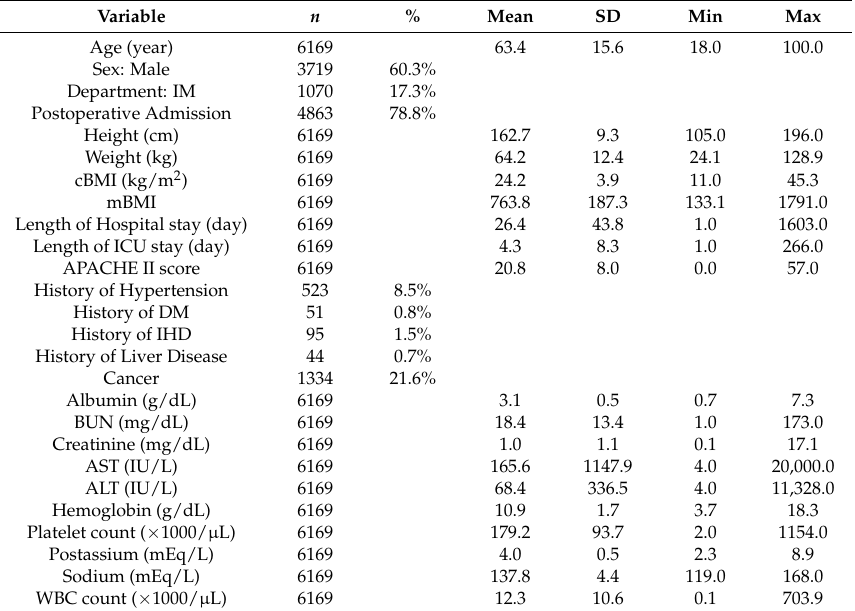
Table 1. Patients’ demographic and clinical